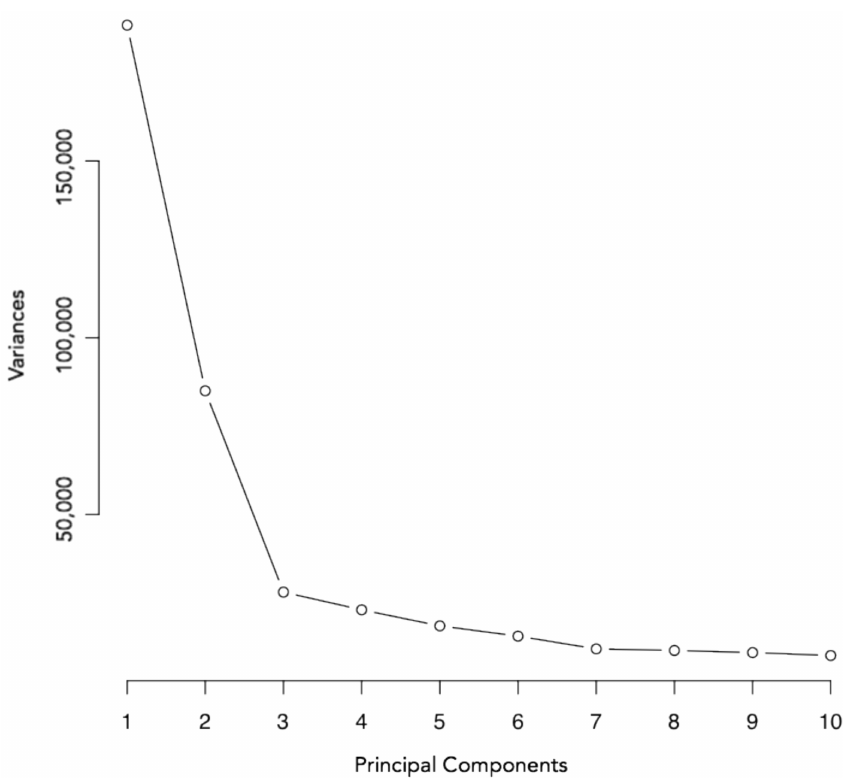
Figure 1. Scree plot generated with M-values for 771,484 probes on the HM850 array. Variance is shown on the y-axis; principal components are shown on the x-axis. Table 2. Principal Component Analysis of factors during pregnancy influencing DNA methylation levels in offspring.